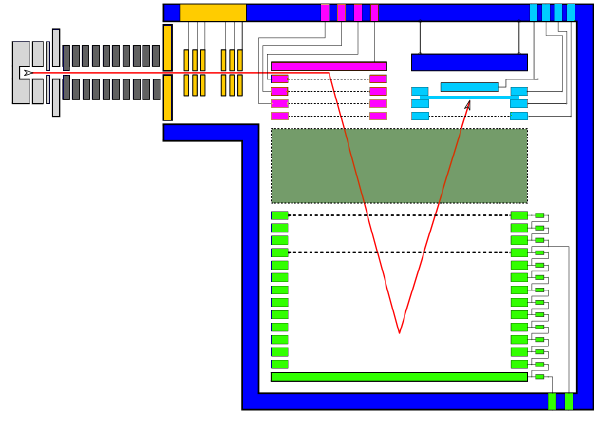
Figure 1. Schematic drawing of the newly developed compact PTR-ToF-MS instrument. The color-coded components are as follows: glow discharge (light grey), ion drift tube (dark grey), ion transfer optics (dark yellow), orthogonal ion accelerator (magenta), field-free time-of-flight region (olive green), double stage ion mirror (light green), post-accelerator and multichannel plate (MCP) detec- tor (light blue). The ion path is shown in red. Housing and mounting parts are shown in deep